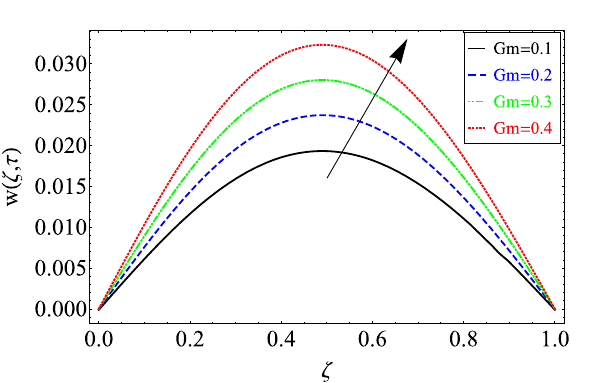
Figure 4. The effect of different values of Gm on velocity distribution of Maxwell nanofluid, when Re = 10 , α = 0.7 , τ = 0.5 , φ = 0.02 , Gr = 0.05 , Pr = 6300 , Sc = 15 and (cid:31) = 0.5